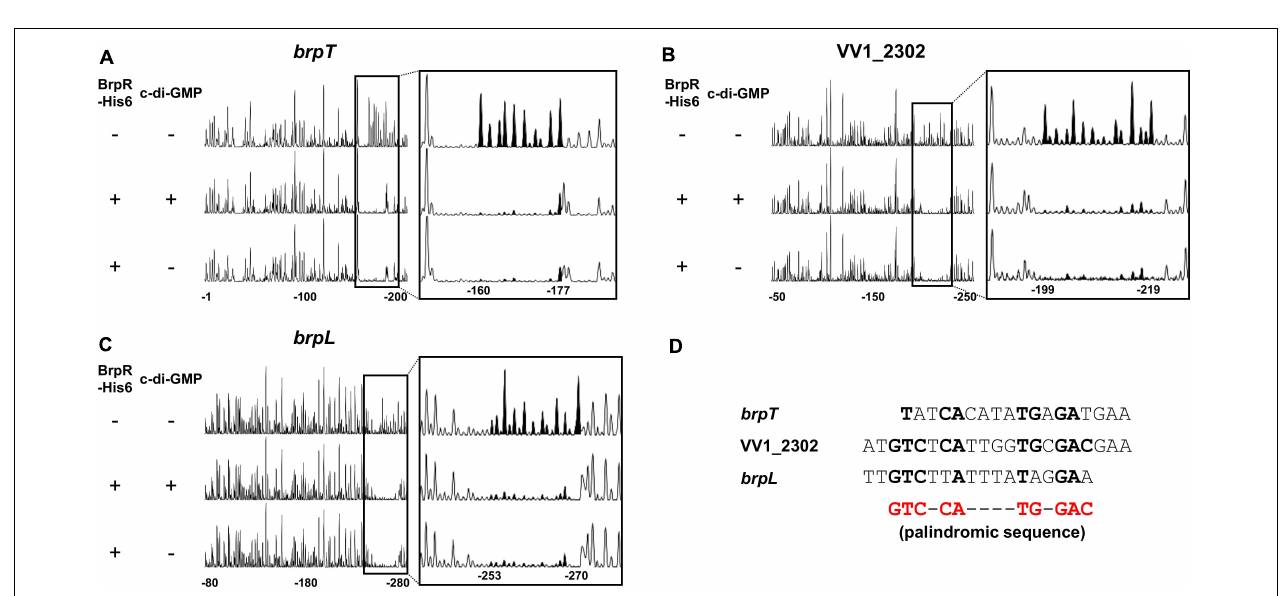
FIGURE 10 | Similar binding affinity of BrpR-His6 in the presence or absence of c-di-GMP. The 6-FAM-labeled DNA fragments (5 nM) for the upstream regions of brpT (A), VV1_2302 (B) , and brpL (C) were incubated with increasing amounts of BrpR-His6 as indicated in the presence or absence of c-di-GMP (50 µ M). B, bound DNA; F, free DNA.